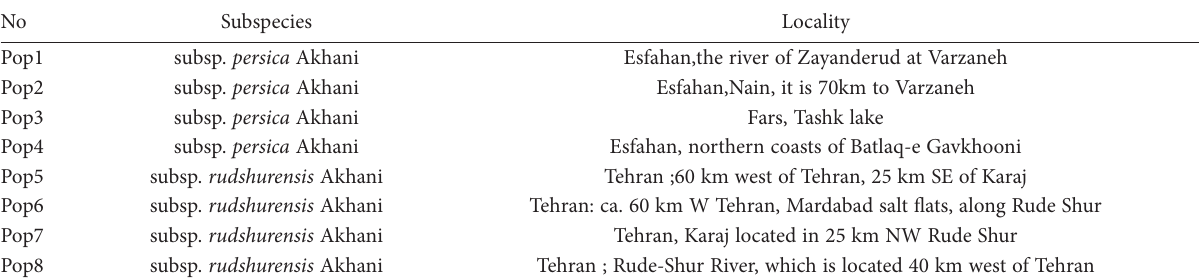
Table 1. Voucher details and diversity within Iranian populations and subspecies of Salicornia persica in this study.